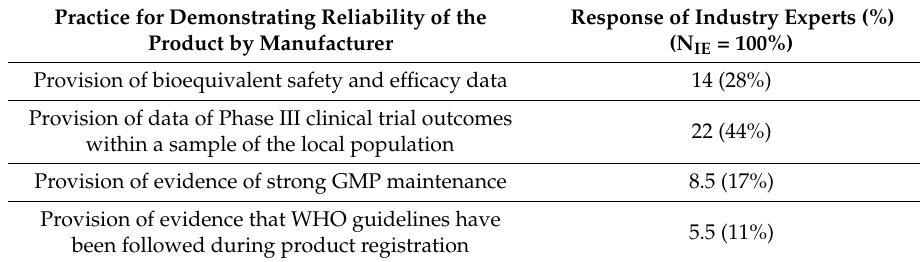
Table 6. Patient Education strategies on the use of biosimilars.